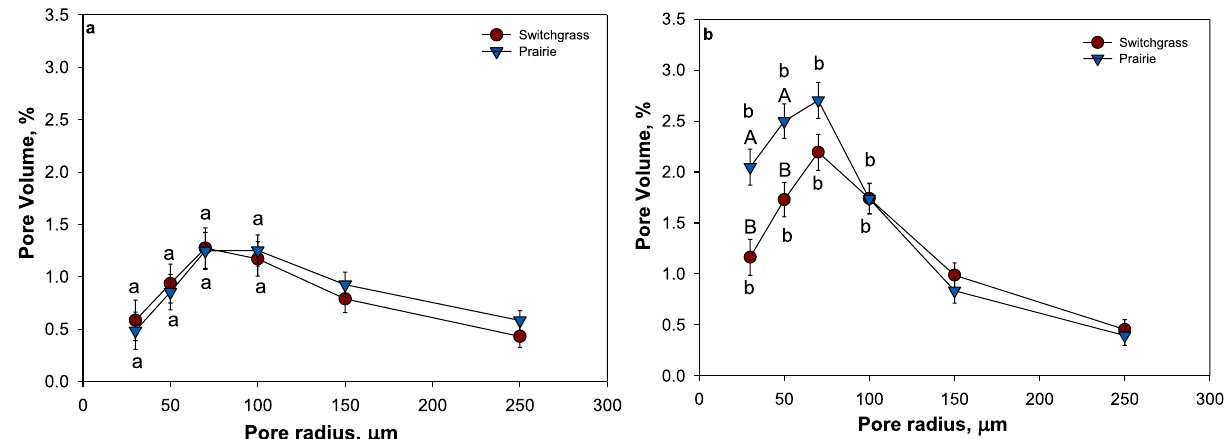
Figure 4. Pore size distribution for > 18.2 μm radius pores from topographical depressions ( a ) and slopes ( b ) in prairie ( ▼ ) and switchgrass ( ● ) cropping systems before plant growth experiment. Shown are means with error bars representing standard errors (n = 6). Lower case letters indicate significant differences between topographical positions within each planting system (p < 0.05); upper case letters indicate significant differences between the cropping systems within each topographical position (p <